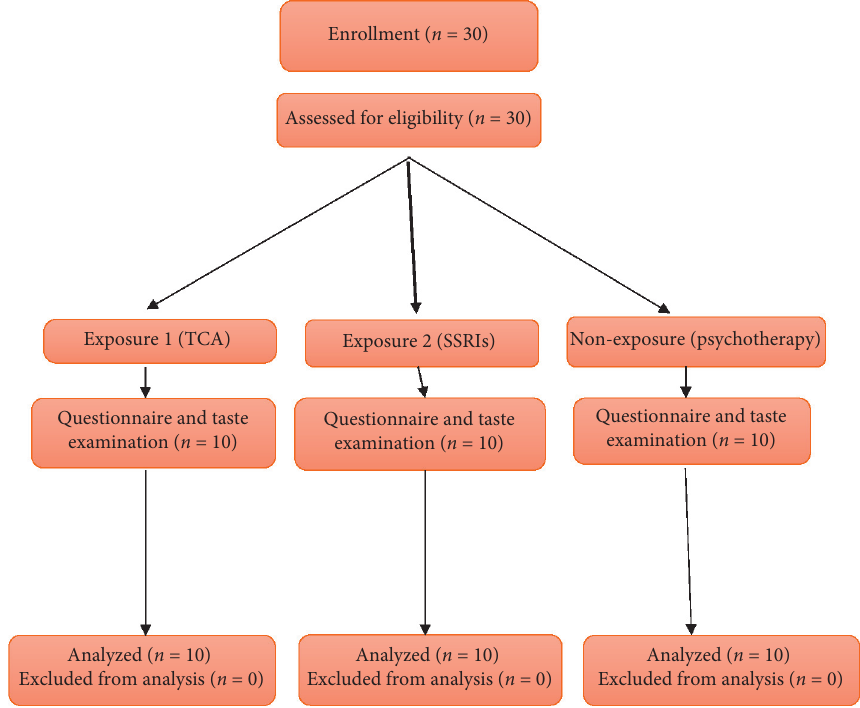
Figure 1: CONSORT flow diagram of the